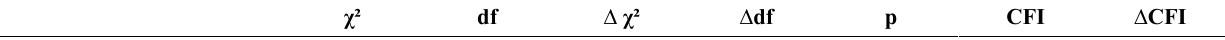
Table 4 Fit indices for the invariance of the measurement model of the PLOCQ in the Portuguese sample across samples, gender, 3 rd cycle and secondary